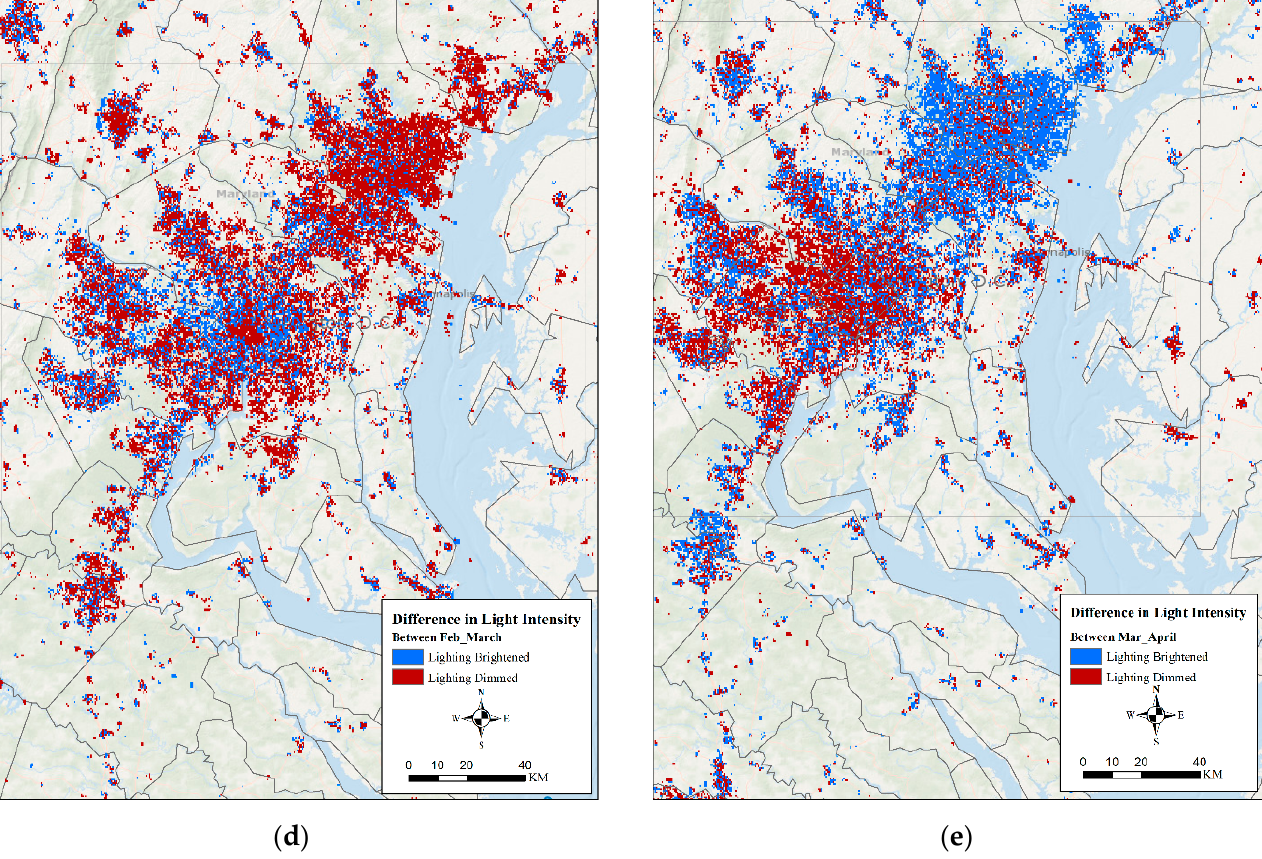
Figure 20. Nighttime light (NTL) intensity distribution from VIIRS for Washington DC in February ( a ), March ( b ), April ( c ); change in NTL intensity in DC between February and March ( d ) and between March and April ( e ).